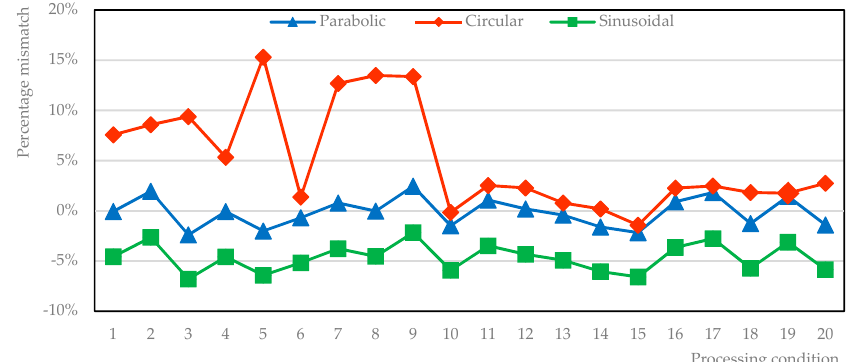
Figure 5. Percentage mismatch, with respect to the actual area of the deposited metal; approximation with semi-ellipse, resulting in wider mismatches, is omitted here.